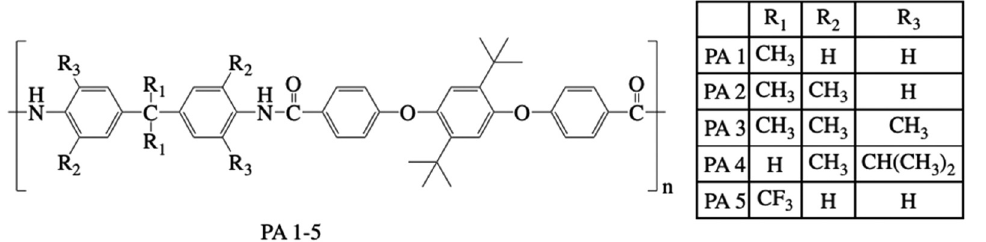
Figure 3: Structure of the PAs having di ff erent alky side substituents ( 24 )